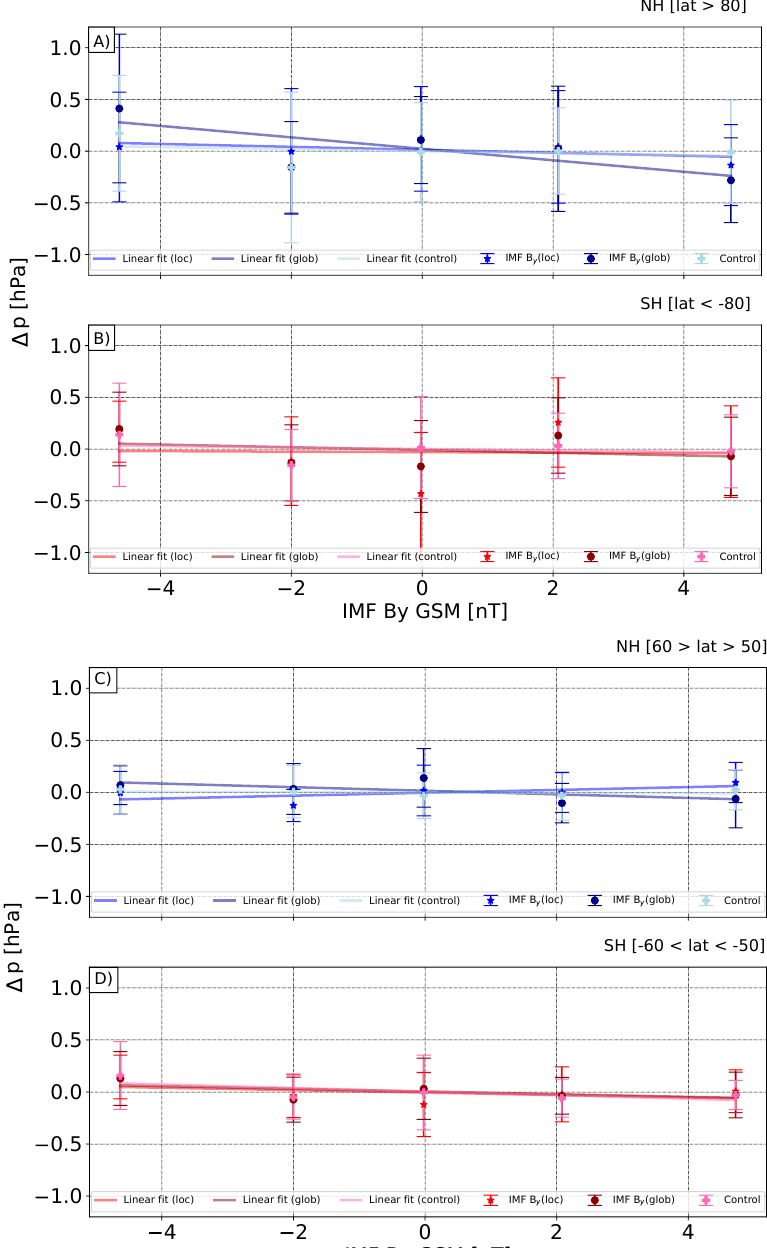
Figure 7. Ensemble-mean linear regression of ∆ p and daily-mean IMF B y for the 1999–2002 period. Data were binned and averaged for five daily-mean IMF B y intervals (see experiment description). Blue and red: B y (loc) experiment; Dark blue and dark red: B y (glob) experiment; light blue and pink: the control experiment. Panels A and B: ∆ p for northern hemisphere ( A : lat>80) and mid-latitudes ( B : 60>lat>50); Panels C and D: ∆ p for southern hemisphere ( C : lat>80) and mid-latitudes ( D : -60<lat<-50). Error bars are plus/minus standard-error-in-the-mean of ∆ p between ensemble members.